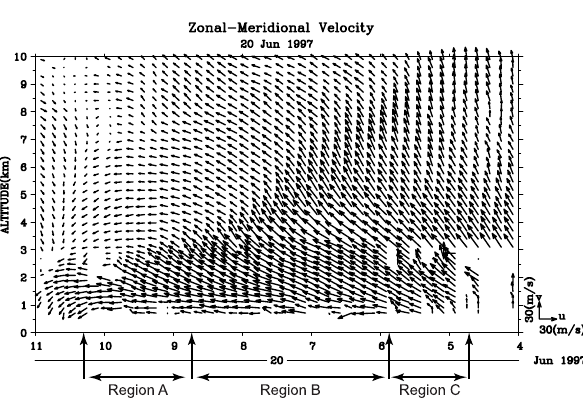
Fig. 5. Temporal variations of rain intensity on the ground at the MU radar site during 0400–1100 LT on 20 June 1997.